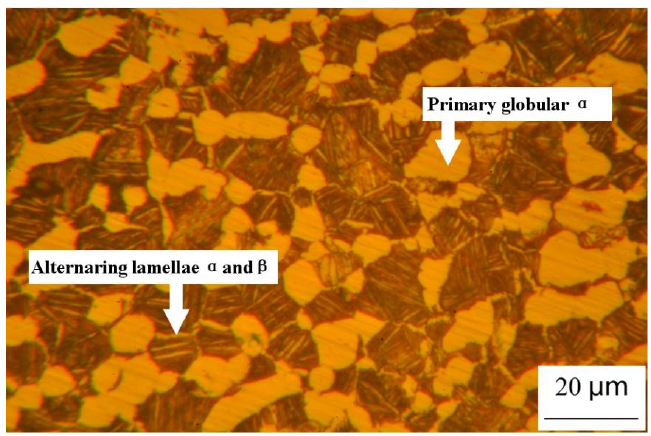
Figure 1. The microstructure of TC11 alloy afer the heat treatment (1228 K for 2 h+ 803 K for 6 h).